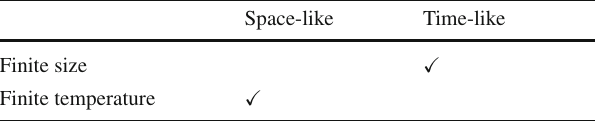
Table 1 The symbol (cid:2) marks a correction to the entanglement entropy caused by the T ¯ T deformation Space-like Time-like Finite size (cid:2) Finite temperature